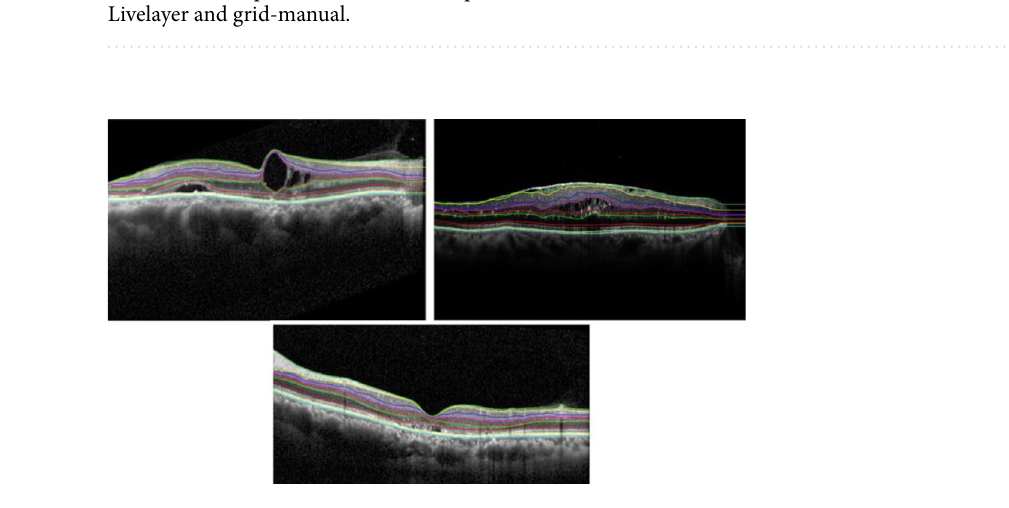
Figure 4. Three different macular B-Scans obtained from patients with DME and segmented by the Livelayer